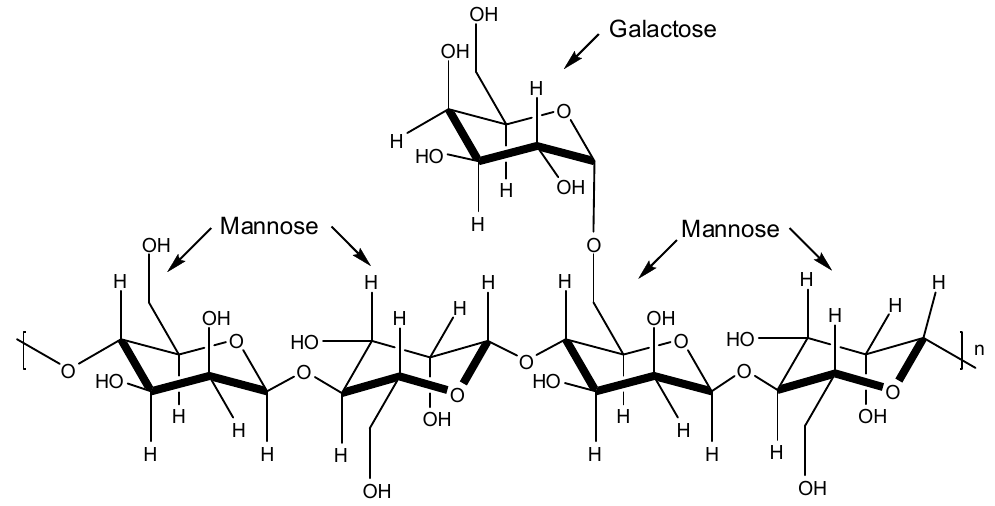
Figure 7. Basic structure of